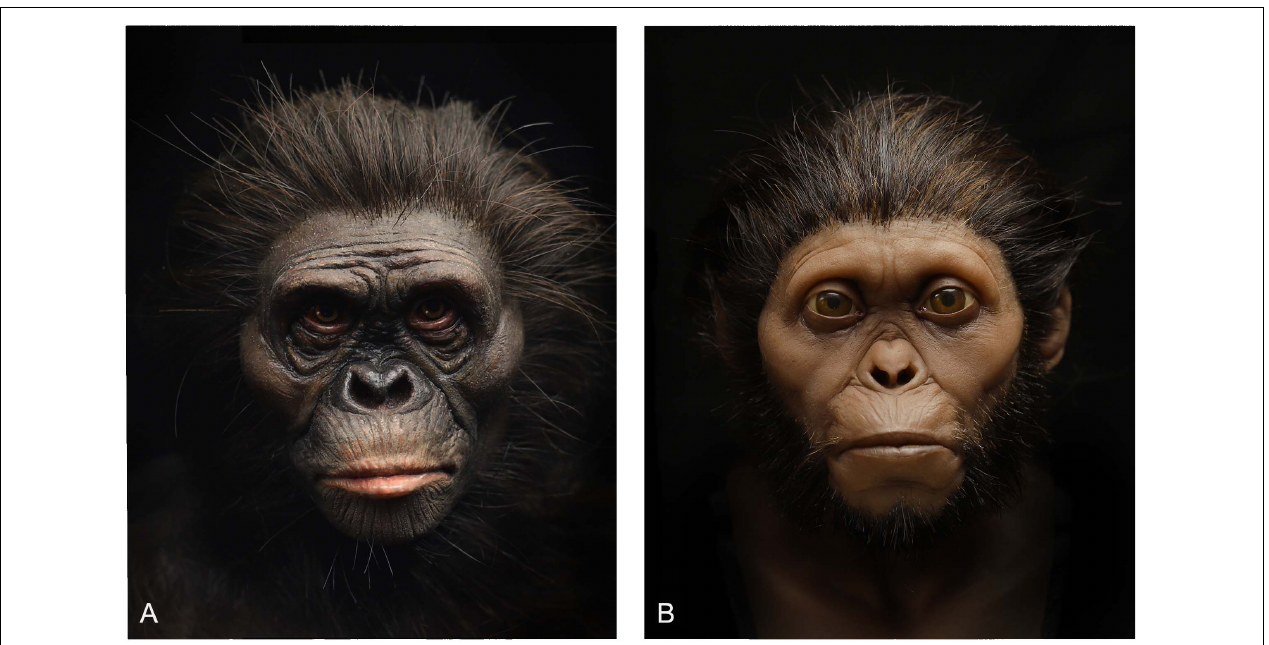
FIGURE 7 | Pigmented silicone casts of facial reconstructions of Lucy (A) and the Taung child (B) showing different skin tones. Lucy’s tone has been reconstructed to appear more similar to that of bonobos, whereas the Taung child’s tone is more similar to that of anatomically modern humans native to South